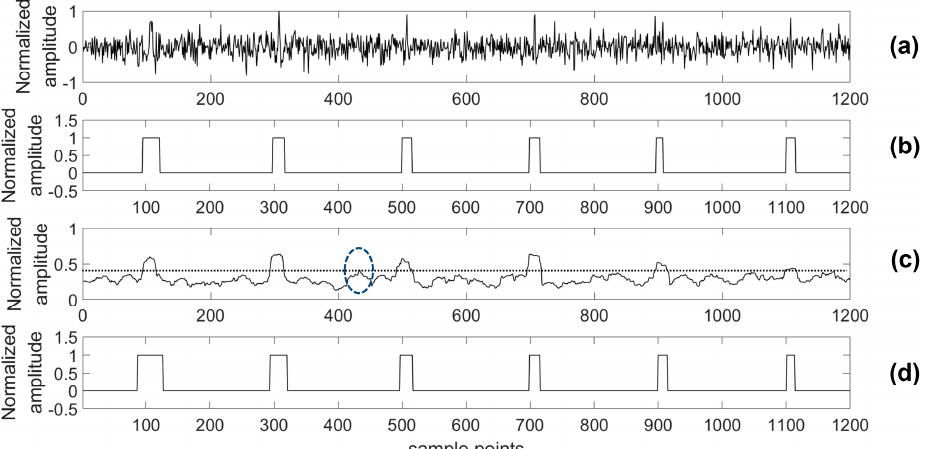
Figure 19. Channel B of test data ( − 15 dB) and its results. ( a ) Test data ( − 15 dB); ( b ) Detection results of the proposed algorithm; ( c ) Detection results of the STA/LTA algorithm; ( d ) The real label.